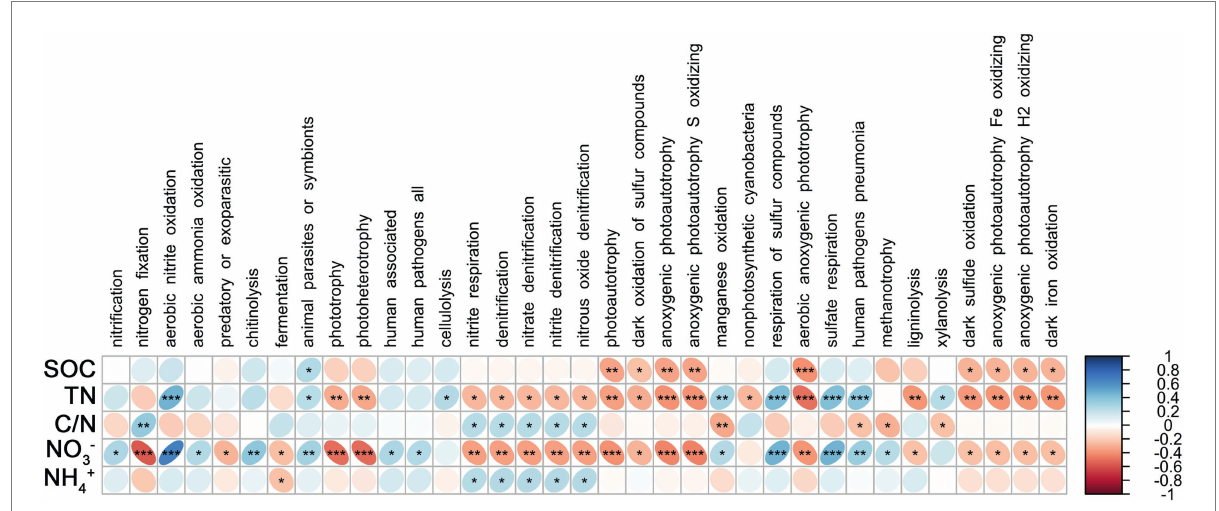
FIGURE 4 Correlations between predicted bacterial functional groups of the root and soil organic carbon (SOC), total nitrogen (TN), C/N ratio (C/N), soil nitrate nitrogen (NO 3 − ), and ammonia nitrogen (NH 4+ ) by Spearman’s rank correlation. Significant difference were indicated as follows: * p < 0.05; ** p < 0.01; *** p < 0.001.